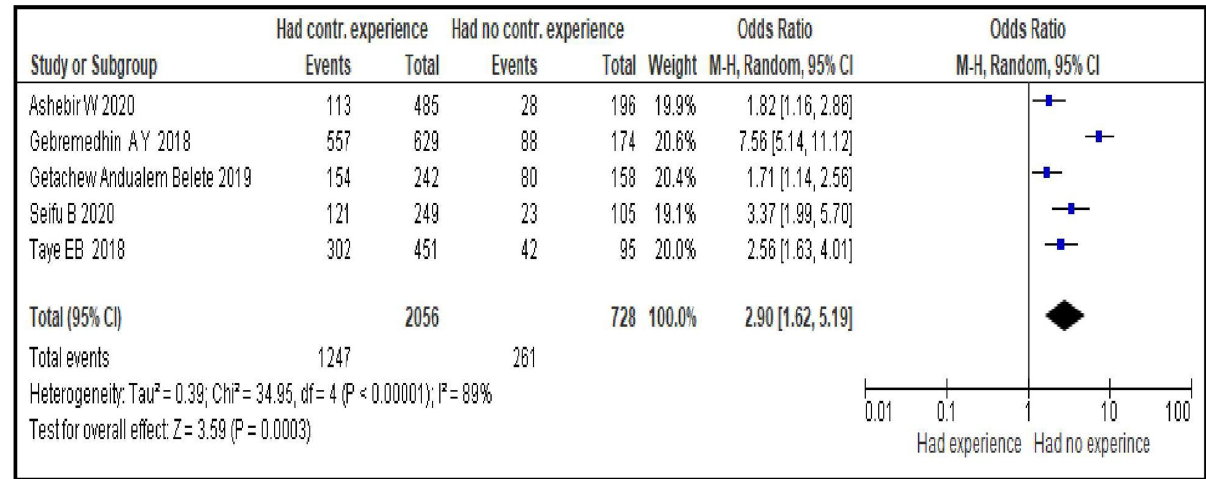
Fig 9. Association between having experience of modern contraceptive use before and modern contraceptive uptake during postpartum period, 2021.